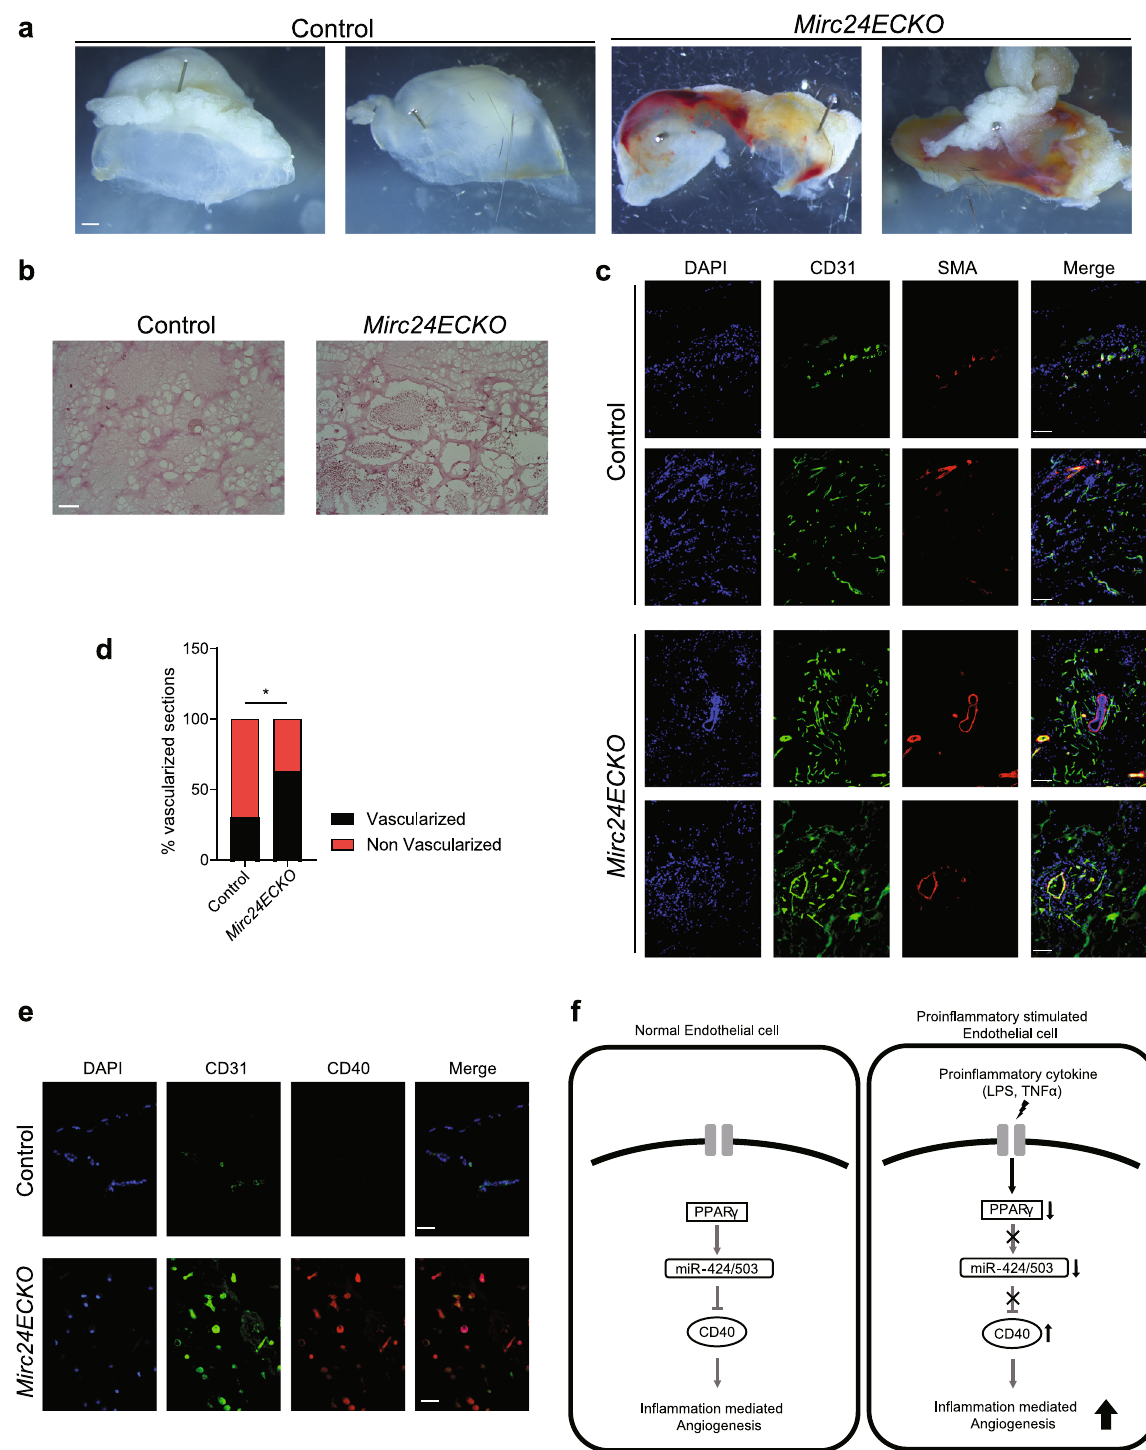
Figure 6. LPS induced angiogenesis is inhibited by Mir24c in vivo . ( a ) Whole mount images and ( b ) H&E stained sections of LPS-containing Matrigel implants, showing increased vascularization in mice lacking the Mir 24 cluster that includes miR-322 (mouse miR-424 ortholog), miR-503, and miR-351 ( Mirc24ECKO ). Scale bar: 100 μ m. ( c ) Immunostaining of LPS-containing Matrigel implant sections for CD31 (green), SMA (red) and DAPI (blue) showing increased vascularization in Mirc24ECKO . Scale bar: 70 μ m. ( d ) Quantification of vascularized/non-vascularized immunostained LPS-containing Matrigel implant sections in control and Mirc24ECKO mice. * P < 0.05 . ( e ) Staining for CD40 (red) in Matrigel implant sections along with CD31 (green) showing increased CD40 expression in infiltrating endothelial cells. Scale bar: 35 μ m. ( f ) Schematic outlining the proposed endothelial